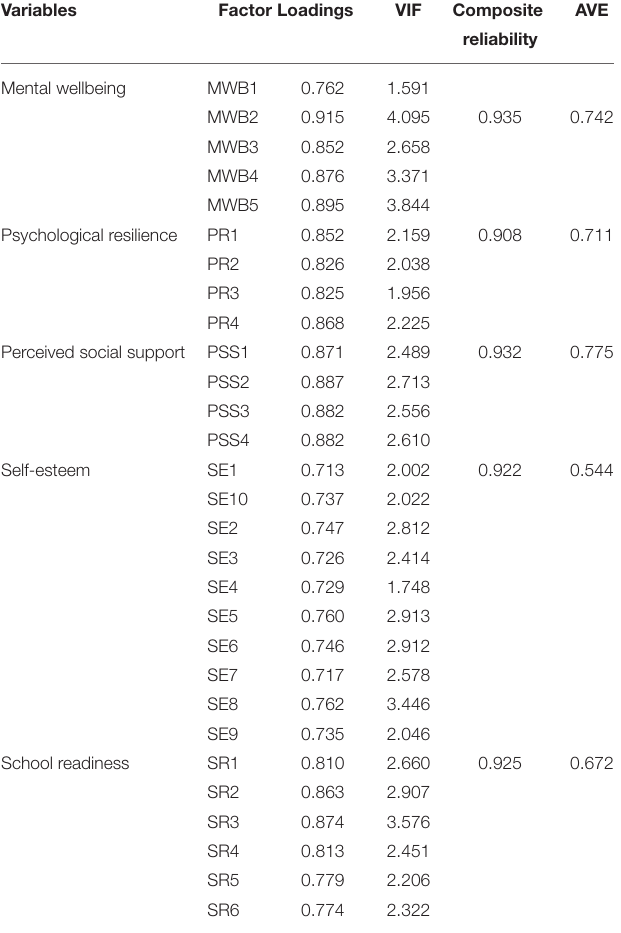
TABLE 4 | Discriminant validity (Fornell and Larcker